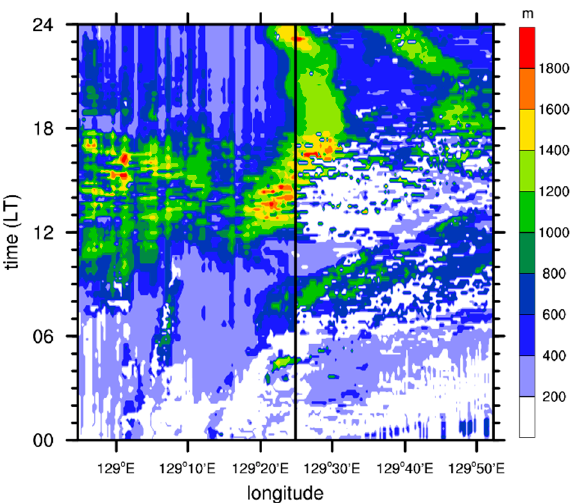
Figure 13. Hovmöller diagram for the simulated planetary boundary layer height along C2. The black solid line indicates the location of Uljin station.